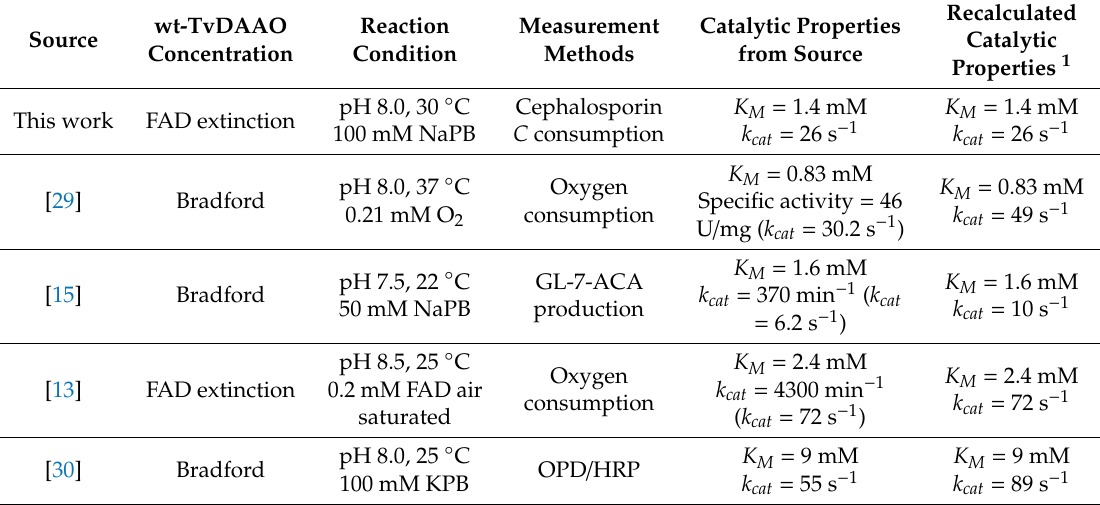
Table 5. Comparison of reported catalytic properties of wt-TvDAAO with cephalosporin C